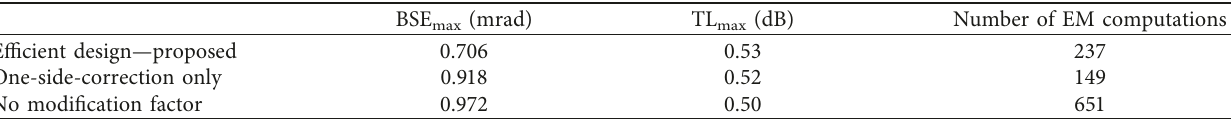
Figure 11: EM performance of VTRs obtained by the proposed method, one-side-correction-only method, and no-modification-factor method. (a) BSE. (b) TL. Table 5: Effect of side selection and modification